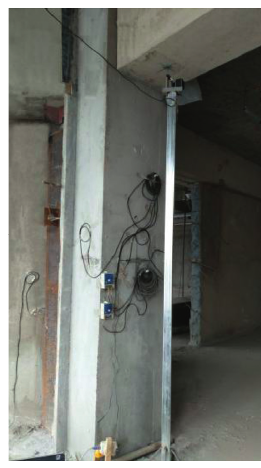
Figure 7: Actual arrangement of strain and displacement measuring